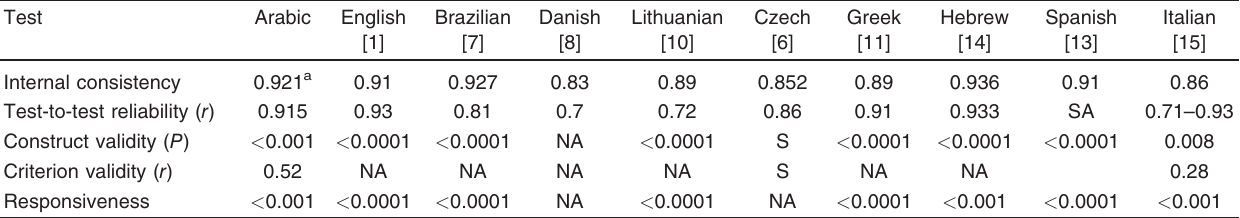
Table 3 Comparison between data of Sino-Nasal Outcome Test 22 translation studies